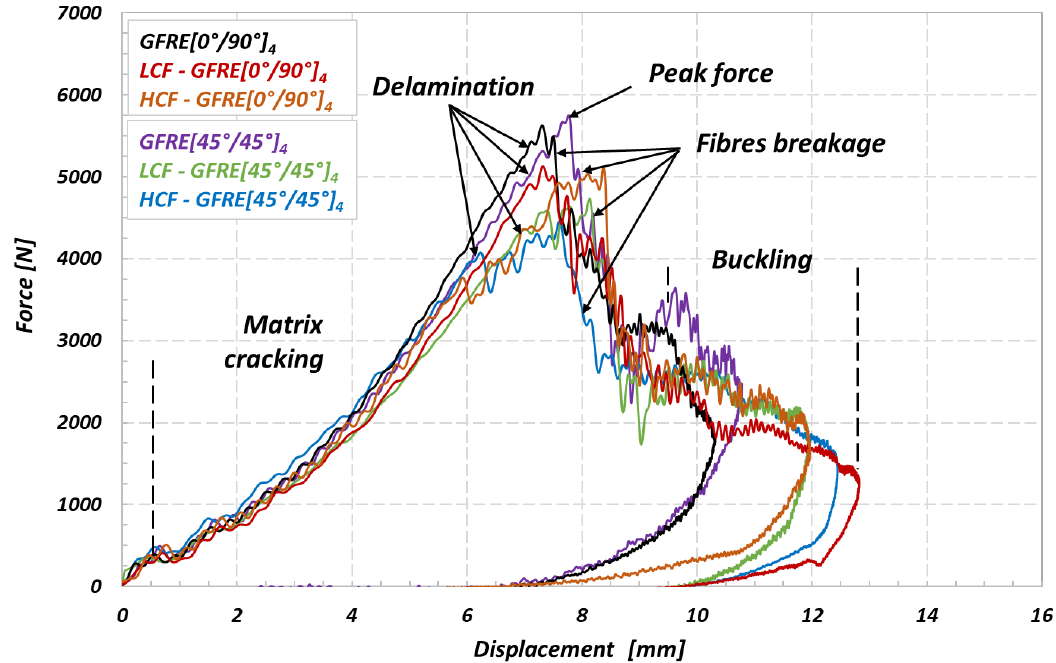
Figure 11. Force–displacement curves of the non-aged and aged GFRE [0 ◦ /90 ◦ ] 4 and GFRE [45 ◦ /45 ◦ ] 4 under different Figure 11. Force – displacement curves of the non-aged and aged GFRE [0°/90°] 4 and GFRE [45°/45°] 4 under different aging processes, the results are for impact energy of 30 J. aging processes, the results are for impact energy of 30